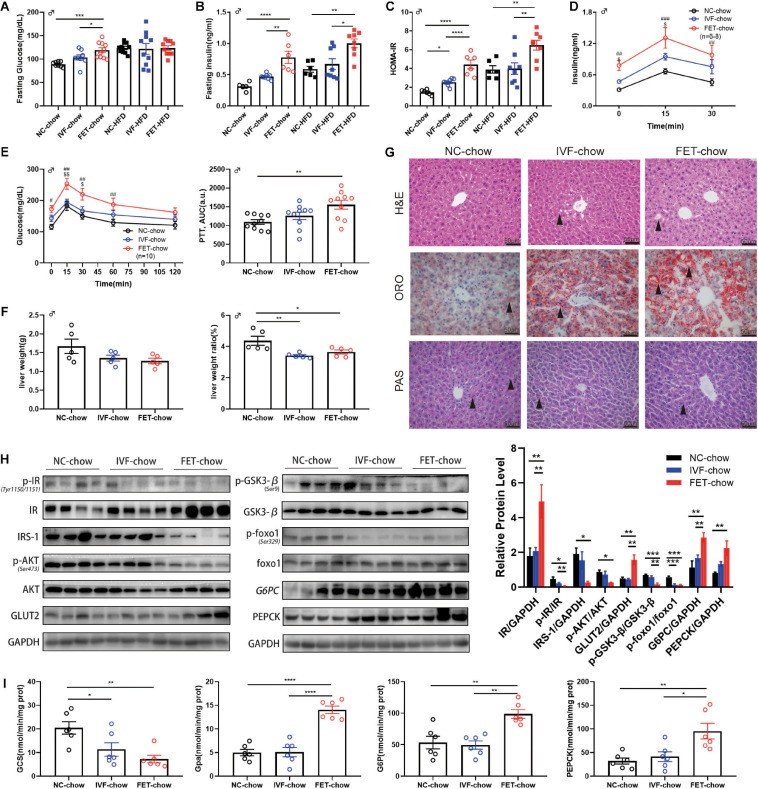
Insulin resistance and impaired hepatic insulin signaling in offspring of the FET-chow group. (A) Serum fasting glucose level in male offspring at 20 weeks old (nNC–chow = 8, nIVF–chow = 8, nFET–chow = 10, nNC–HFD = 10, nIVF–HFD = 10, and nFET–HFD = 10). (B) Serum fasting insulin level in male offspring at 20 weeks old (nNC–chow = 6, nIVF–chow = 8, nFET–chow = 6, nNC–HFD = 6, nIVF–HFD = 8, and nFET–HFD = 8). (C) HOMA-IR index in male offspring at 20 weeks old (nNC–chow = 6, nIVF–chow = 8, nFET–chow = 6, nNC–HFD = 6, nIVF–HFD = 8, and nFET–HFD = 8). (D)
In vivo glucose-stimulated insulin secretion test in chow-fed male offspring at 20 weeks old (nNC–chow = 6, nIVF–chow = 8, and nFET–chow = 6). (E) Pyruvate tolerance test and AUC in 20-week-old chow-fed male offspring (n = 10 mice per group). (F) Liver weights and liver weight/body weight ratios in chow-fed male offspring at 20 weeks old (n = 5 mice per group). (G) Liver morphology, H&E, ORO, and PAS staining (scale bar = 50 (μm). (H) Representative protein levels in chow-fed male offspring livers at 20 weeks old (n = 4 mice per group). (I) Enzymes activities in chow-fed male offspring livers at 20 weeks old (n = 6 mice per group). All data were expressed as the mean (SEM #P < 0.05 FET-chow vs NC-chow; ##P < 0.01 FET-chow vs NC-chow; ###P < 0.001 FET-chow vs NC-chow; $P < 0.05 FET-chow vs IVF-chow; and $$P < 0.01 FET-chow vs IVF-chow (ANOVA).